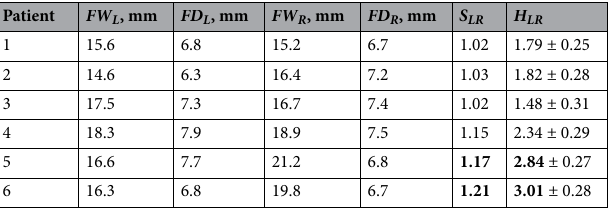
Table 3. Proposed negative volume symmetry metrics S LR and H LR , and the rudimentary linear measurements currently used in clinics (“FW” and “FD” marked in Fig. 1). Bold font indicates the unhealthy joints.